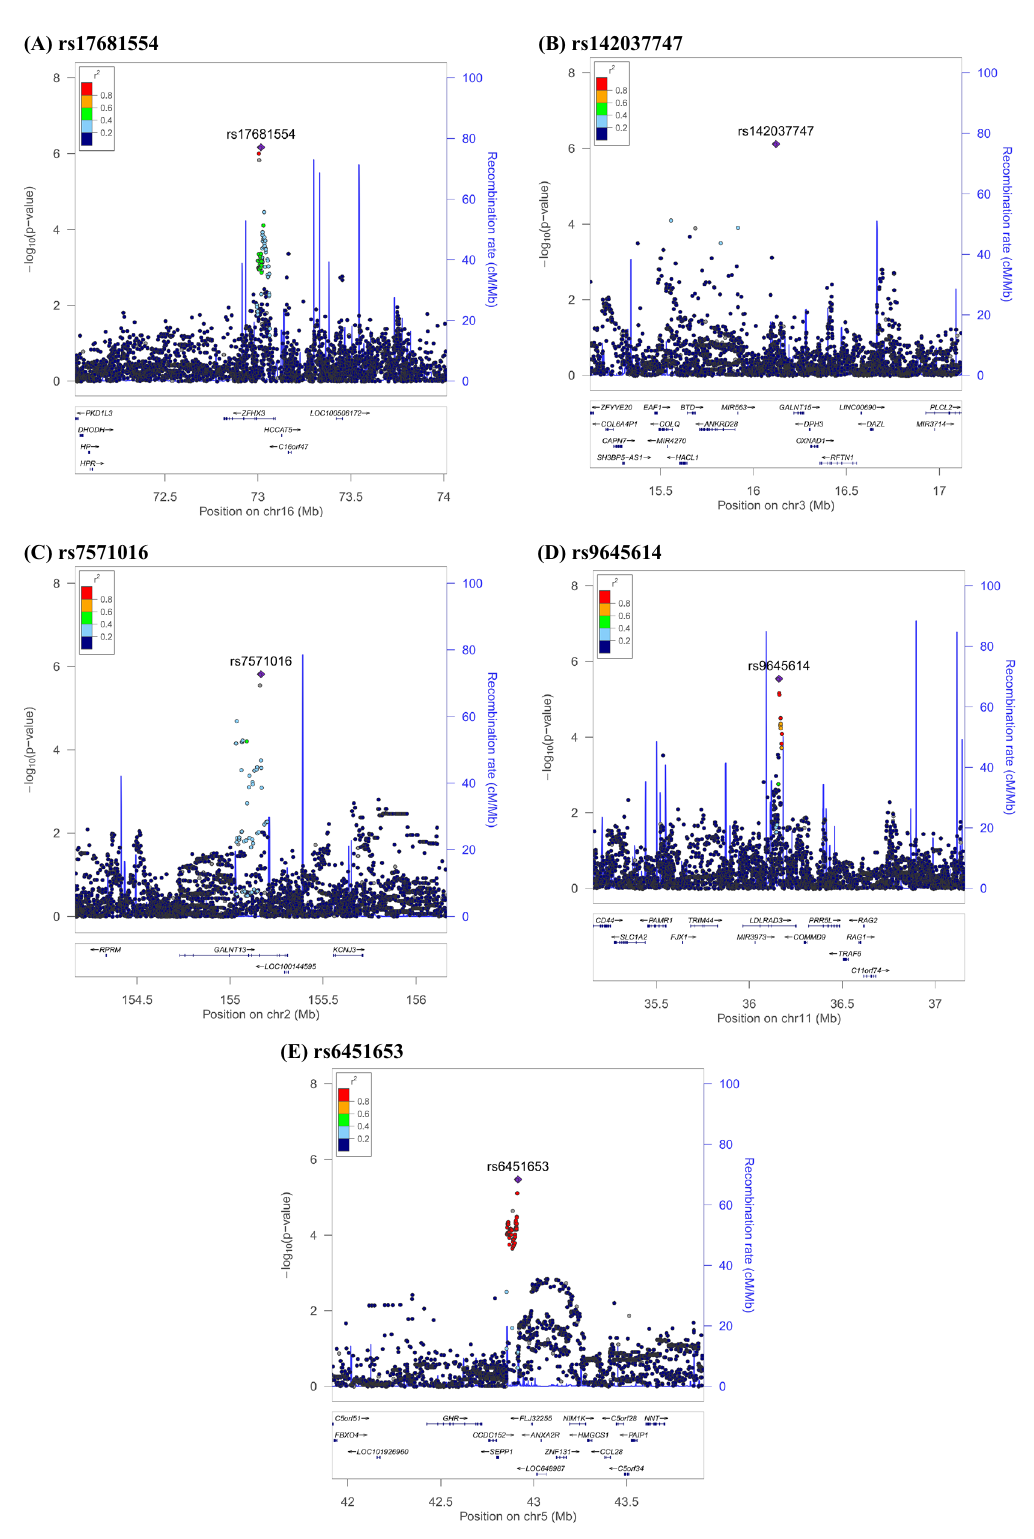
Figure 3. Regional association plots of log UMCR. ( A ) rs17681554, ( B ) rs142037747, ( C ) rs7571016, ( D ) rs9645614, ( E )